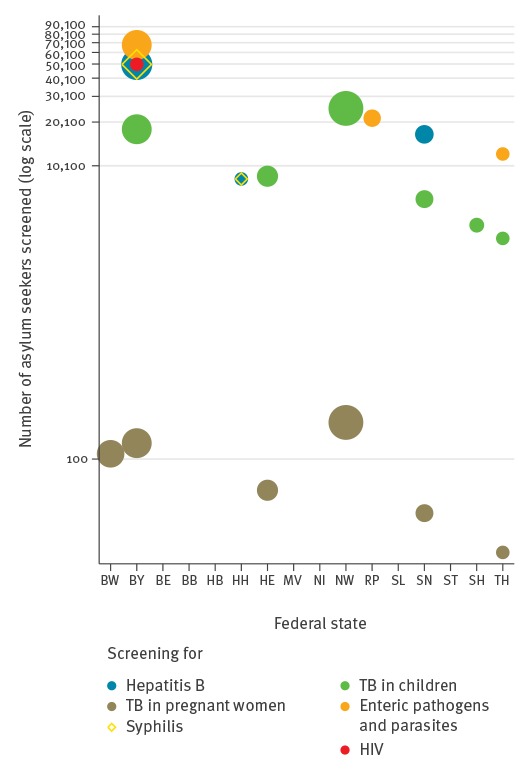
Weighted scatter plot of the estimated number of asylum seekers affected by mandatory diagnostic tests, by federal state, Germany, 2015 (n = 441,899 first-time applicant asylum seekers)